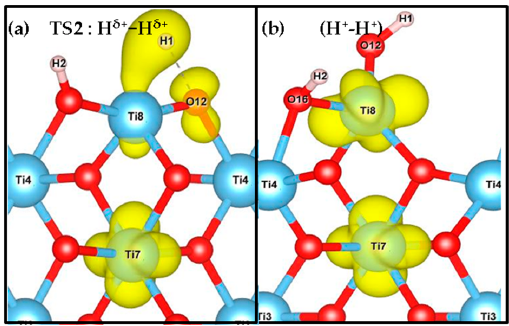
Figure 5. Total and projected densities of state (PDOS) of the TiO 2 slab, *H 2 , TS, *(H + , H − ), and *(H + -H + ) for the (001) ( left ) and (100) ( right ) surfaces. For the PDOS, only the Ti and O involved in the two processes are projected. Positive density of states (DOS) correspond to spin up and negative to spin down.